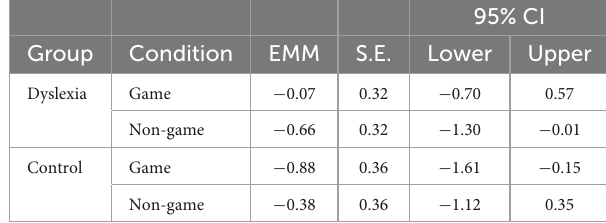
TABLE 2 Estimated marginal means (EMM) of the MMN amplitude changes between the pre-measurement and the post-measurement in µ V for the dyslexia group and the control group for the game and non-game